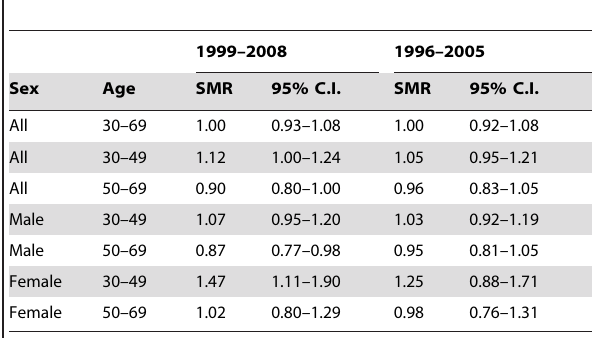
Table 3. Proposed 10-year observation period, with three years of daily re-sampling.